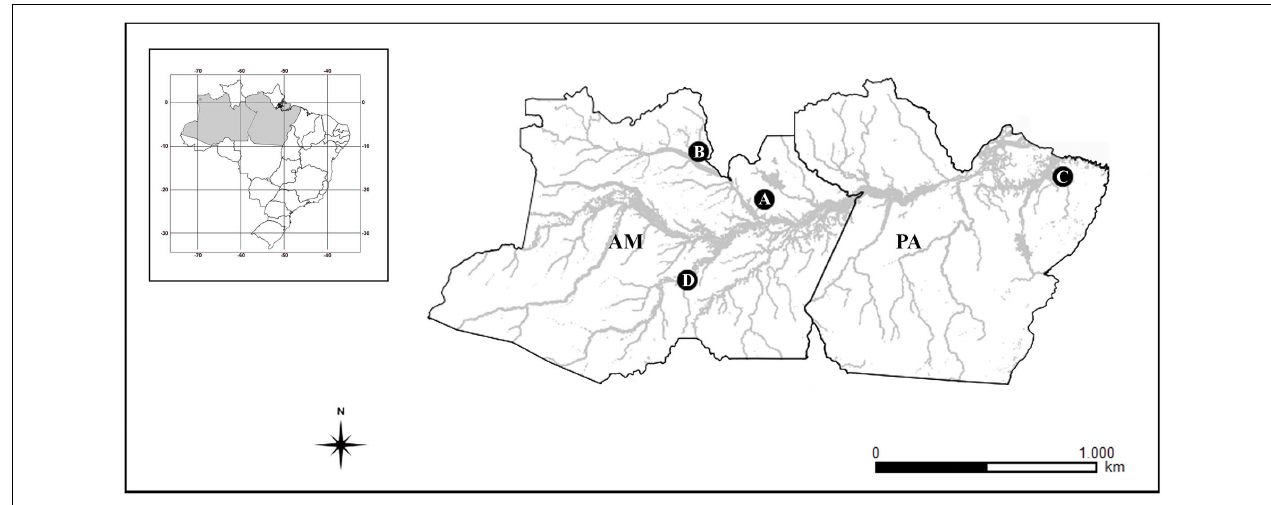
FIGURE 1 | Amazonas (AM) and Pará (PA) Brazilian states map, highlighting the collection sites of the analyzed species. (A) ESU-A Igarapé Jundiá – Cuieiras River, (B) ESU-B Demini River, (C) ESU-C Igarapé Apeú – Guamá River, and (D) SEU-D 1 − 14 Purus River.